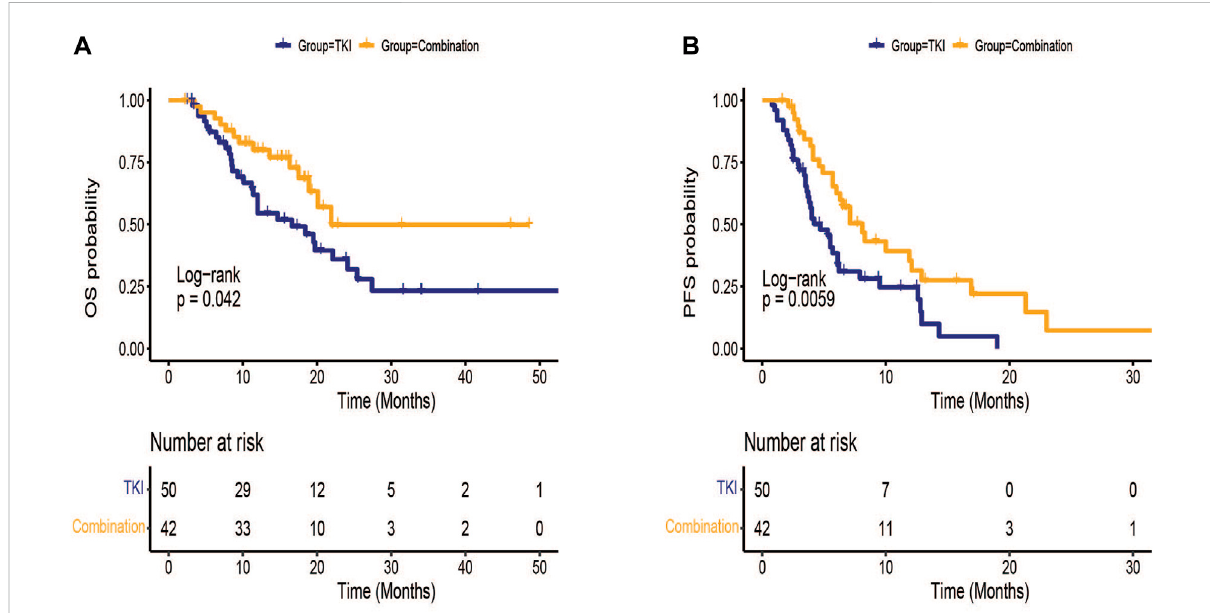
FIGURE 1 Kaplan-Meier survival curves of treatment outcome including (A) overall survival (OS) and (B) progression-free survival(PFS) between TKI group and combination